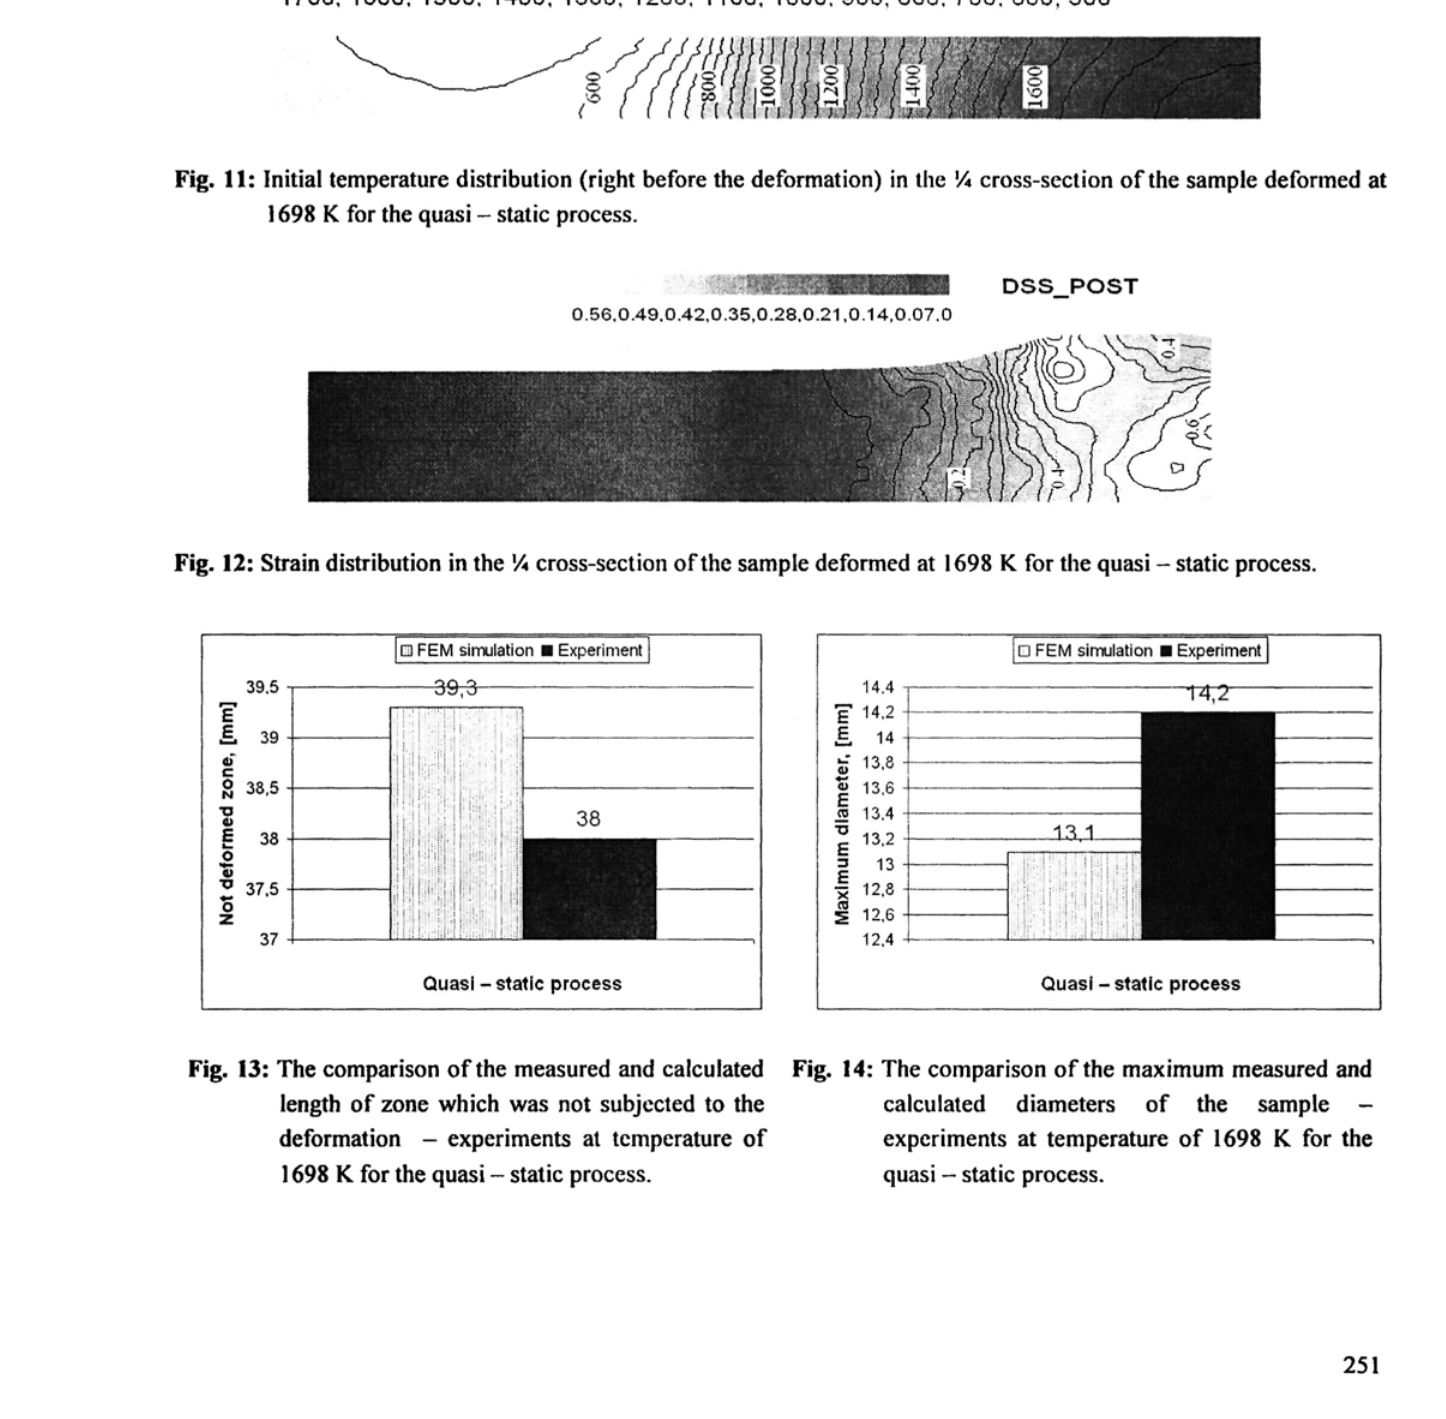
Fig. 13: The comparison of the measured and calculated Fig. 14: The comparison of the maximum measured and length of zone which was not subjected to the calculated diameters of the sample - deformation - experiments at temperature of experiments at temperature of 1698 Κ for the 1698 Κ for the quasi — static process. quasi — static process.